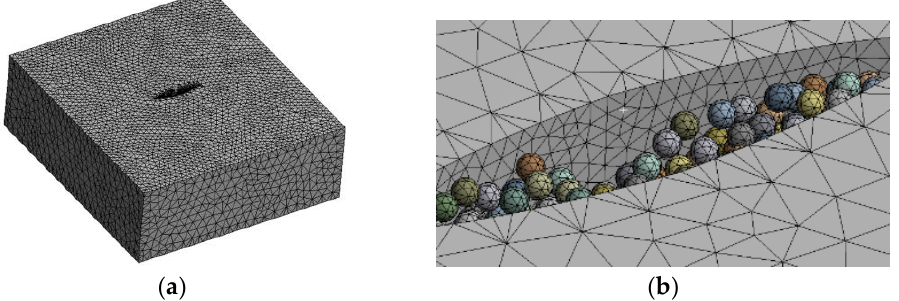
Table 2. Number of the nodes and elements.